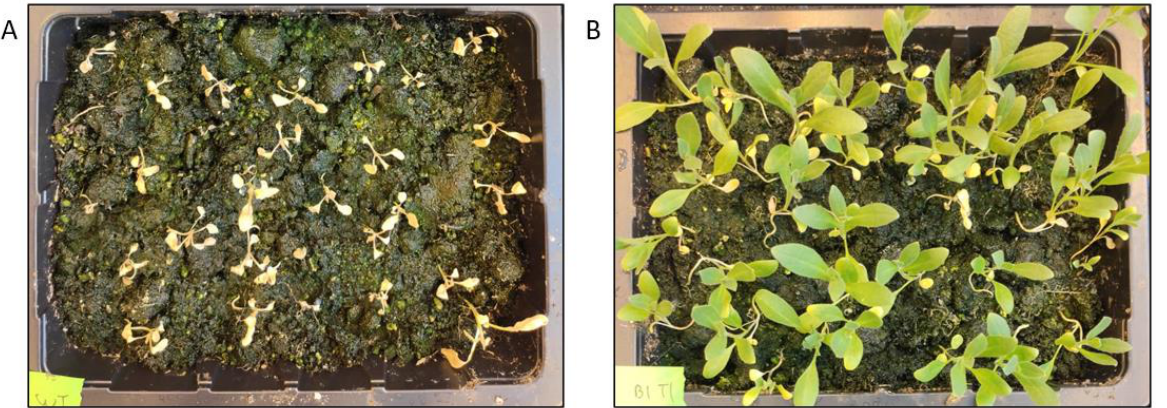
Figure 3. BASTA on-soil selection of T2 transformants. Soil-grown transformants were selected by spraying with 100 mg/mL BASTA starting from the two-leaf stage. The picture was taken after spraying three times in total, approximately two weeks after the first dose. ( A ) WT Camelina sativa ( B ) Segregating pB2GW7-G8O transformants.